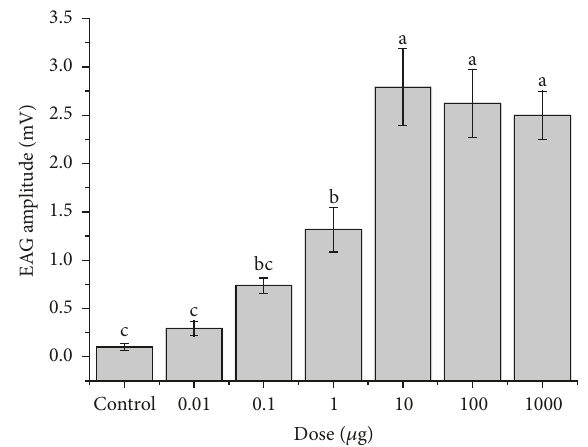
Scheme 2: Synthesis of the target compounds.